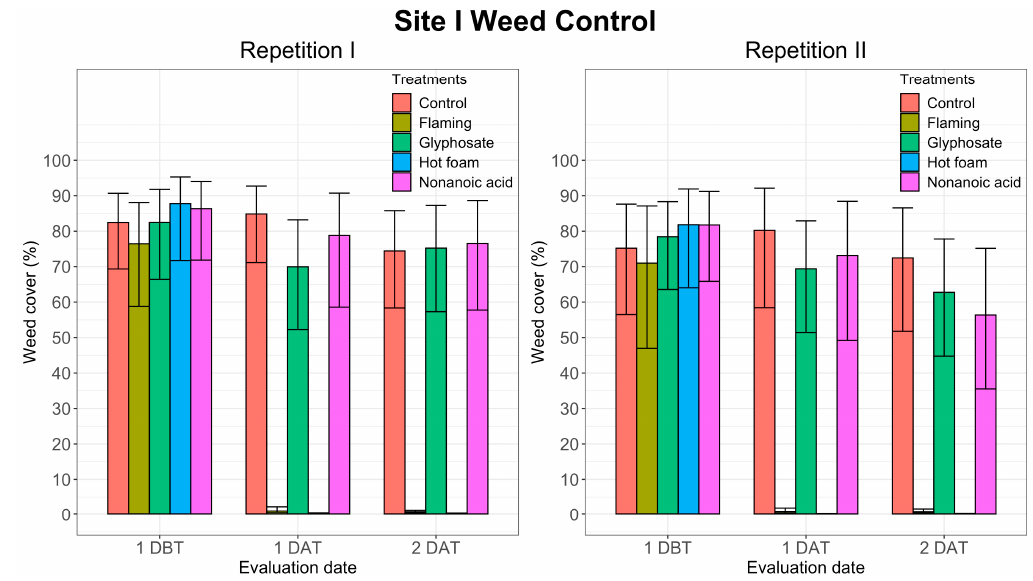
Figure 2. Weed control bar graph of back-transformed means (Table 2) and the 95% confidence interval as affected by the treatments (control, flaming, glyphosate, hot foam and nonanoic acid), repetition (I and II) and evaluation date at site I; 1 DBT, 1 DAT and 2 DAT: one day before, and one and two days after the treatment, respectively. Table 3. Weed control least squares means and SE of weed cover percentage logit transformed as affected by the different treatments, repetition of the experiment, and evaluation date (one day before, and one and two days after treatments) at site II.